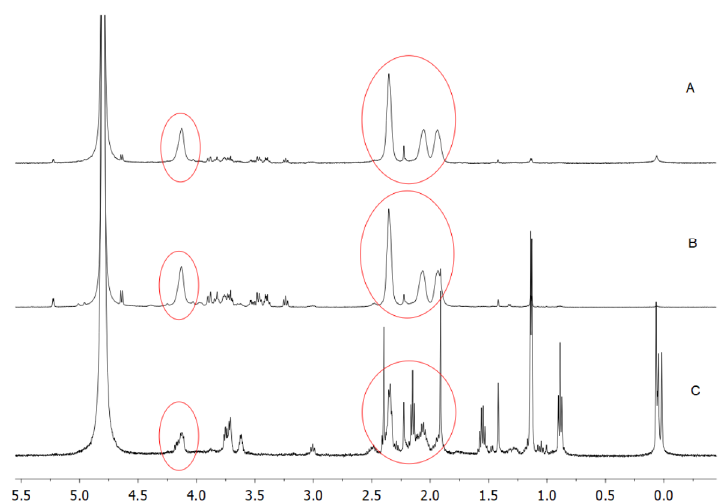
Figure 7. 1 H-NMR spectra of PGA contained in R1 ( A ), R2 ( B ), and R3 ( C ). The circled peaks indicate the homopolypeptide signal [22], whereas the 4.8 ppm peak corresponds to HDO present in the solvent (D 2 O). Further experimental details are given in the text.